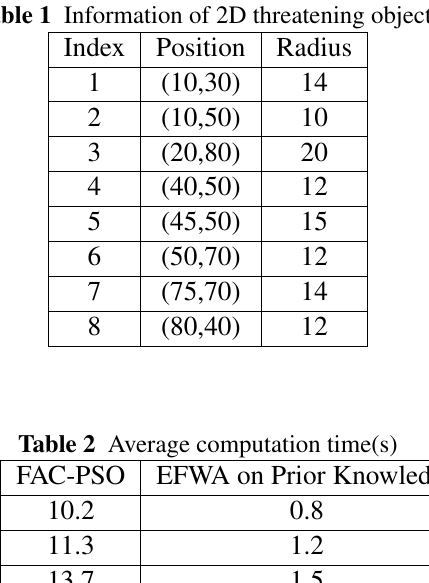
Fig. 9 The iterative calculation pseudo-codes of optimization space between the start point and target